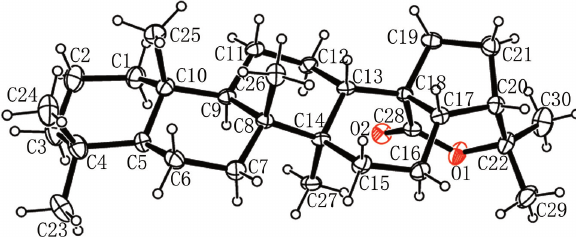
Table 1: Data collection and handling.